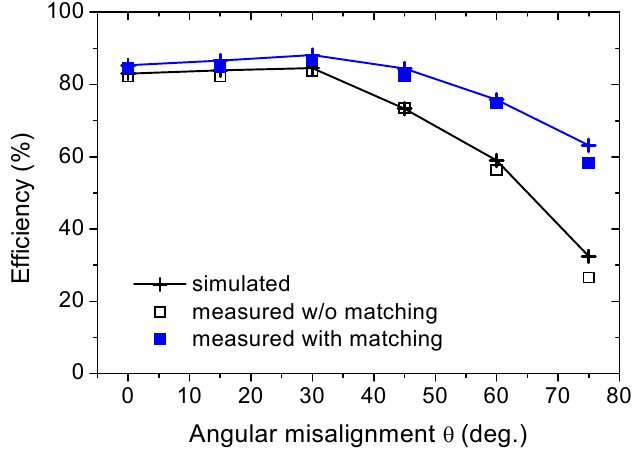
Figure 19. Efficiency comparison as a function of angular